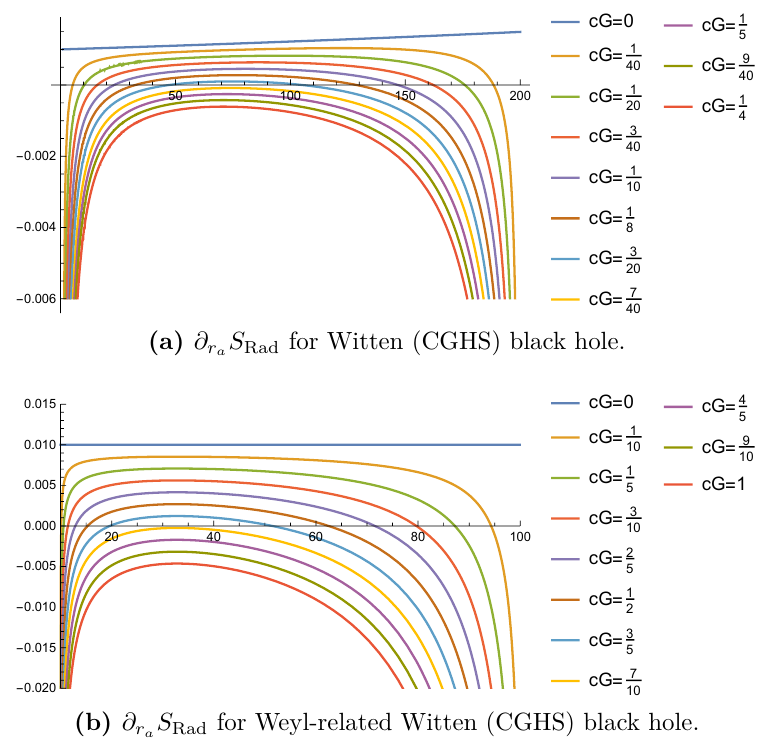
Figure 9. r h = 10 , r b = 200 , λ p = L = 1 , λ = 10 − 3 for Witten black hole and r h = 10 , r b = 100 , λ p = L = 1 , λ = 10 − 2 for Weyl-related Witten black